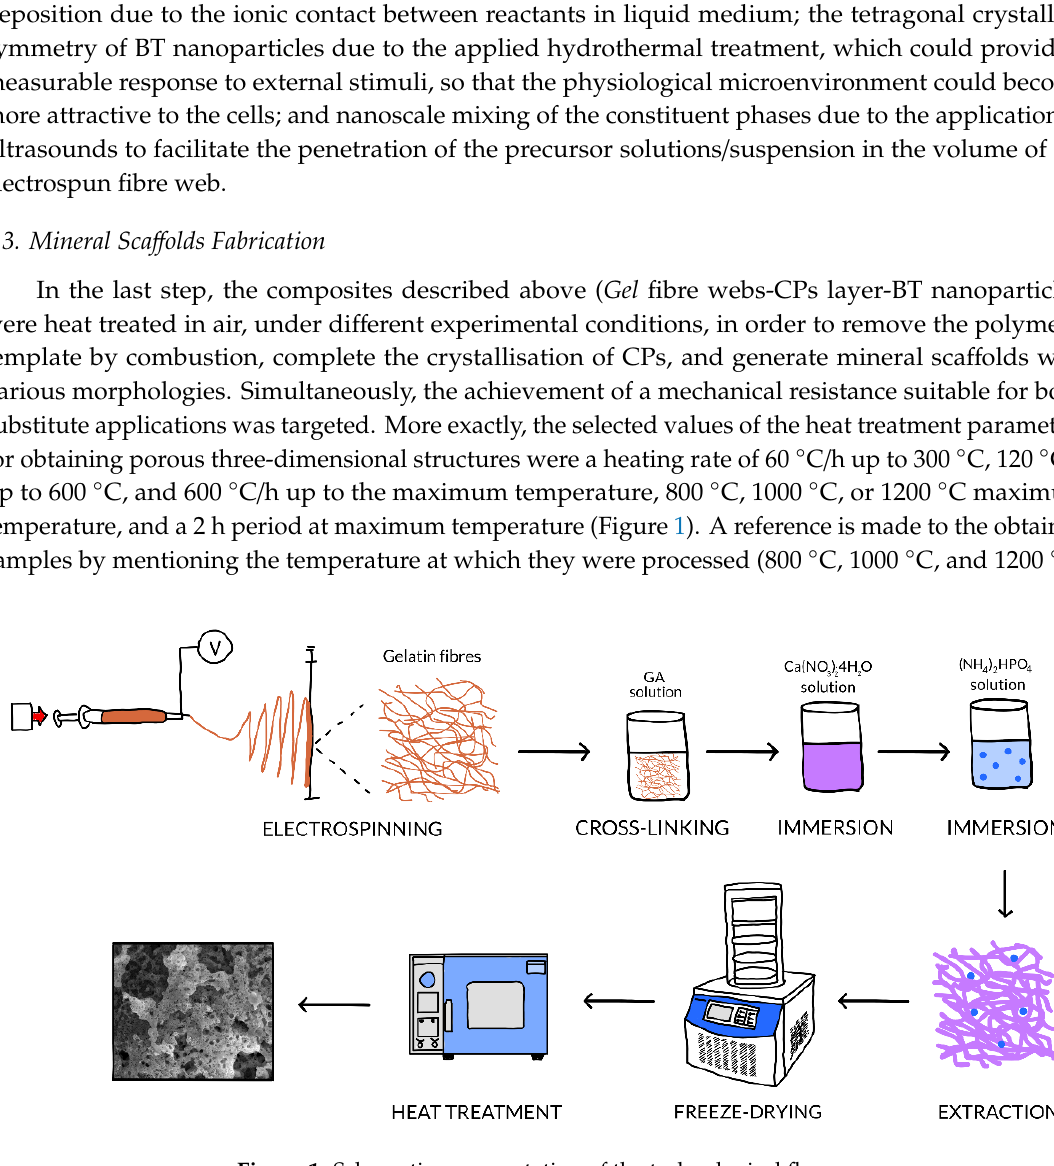
Figure 1. Schematic representation of the technological flow.